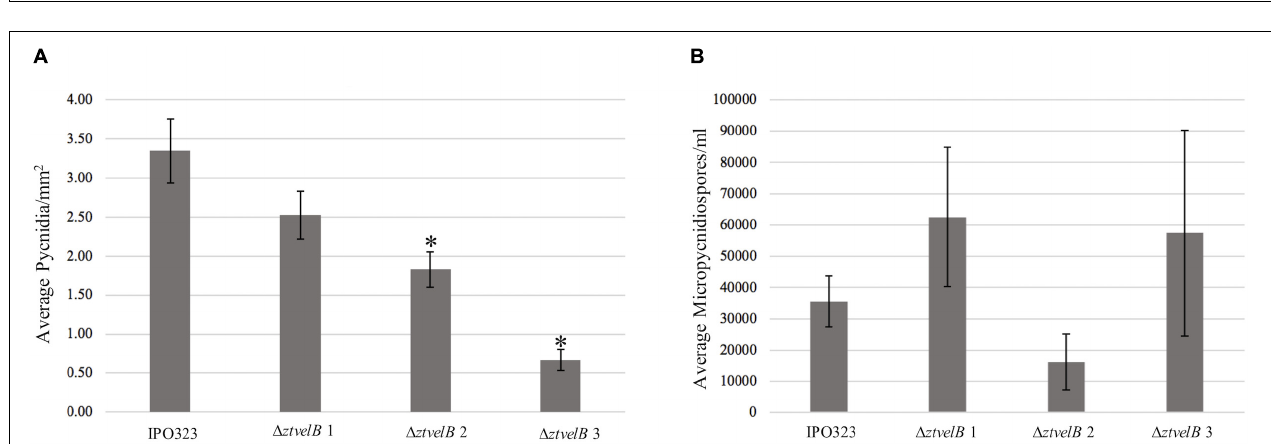
FIGURE 6 | Comparison of the average pycnidia/mm 2 and micropycnidiospores/ml produced by IPO323 compared to the three (cid:49) ztvelB mutant strains at 28 dpi. Experiments were carried out in triplicate with 7–12 technical replicates each time. Bars represent standard error and an asterisk ( ∗ ) signifies strains significantly different to the IPO323 strain. (A) The (cid:49) ztvelB 2 and (cid:49) ztvelB 3 mutants produced significantly fewer pycnidia than the IPO323 strain at the 5% level. (B) The three (cid:49) ztvelB mutants do not produce statistically significantly numbers of micropycnidiospores compared to the IPO323 strain at the 5% level.